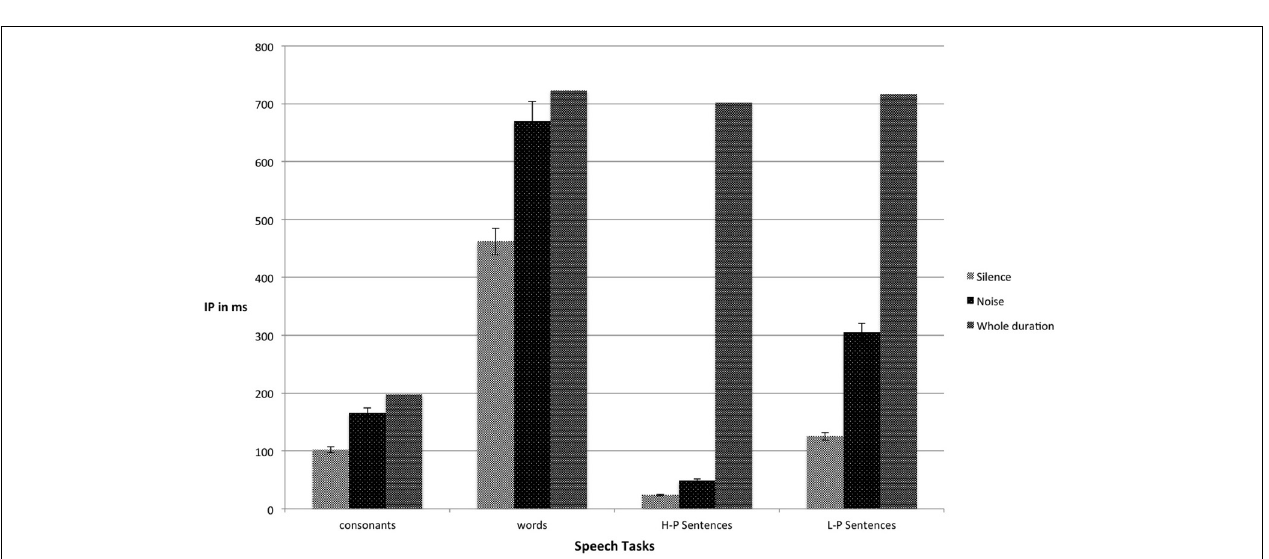
mean IPs of final words in HP sentences in silence ( M = 23 . 96, SD = 3 . 31) occurred earlier than in noise ( M = 48 . 57, SD = 23 . 01), t (20) = 4 . 96, p < 0 . 001, d = 1 . 43. We also analyzed our data by including only correct responses. The results showed that the mean IPs for consonants were 98.26 ( SD = 7 . 98) ms in silence and 137.83 ( SD = 21 . 95) ms in noise. In words, the mean IPs in silence were 456.31 ( SD = 21 . 49) ms in silence and 505.89 ( SD =